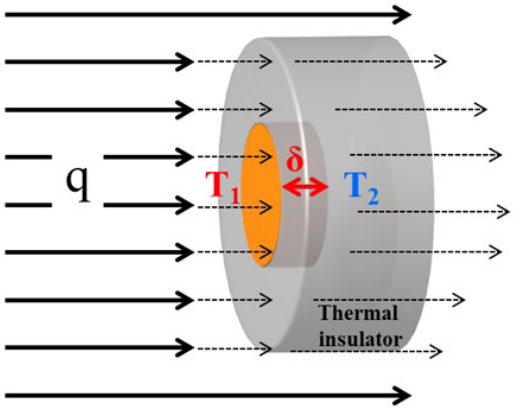
Figure 3. Schematic drawing of the